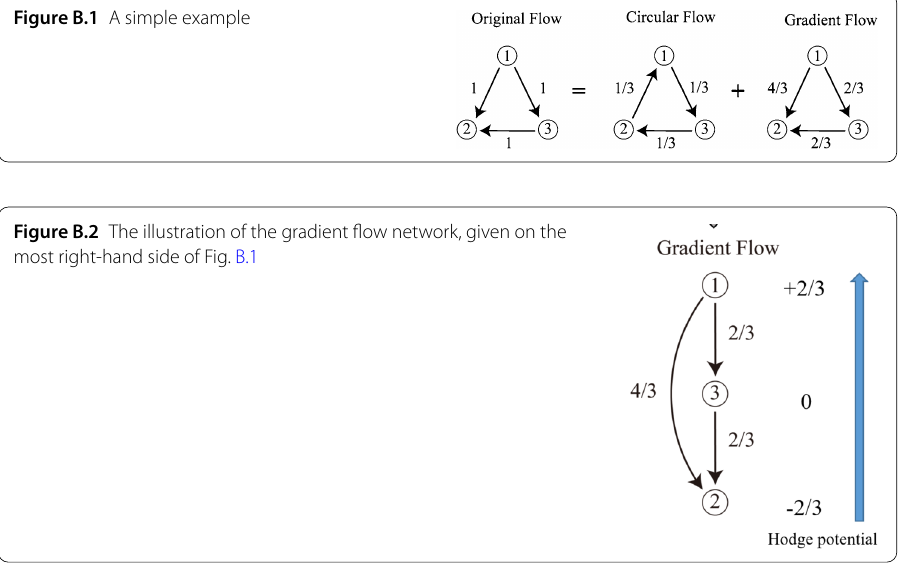
Figure B.1 A simple example